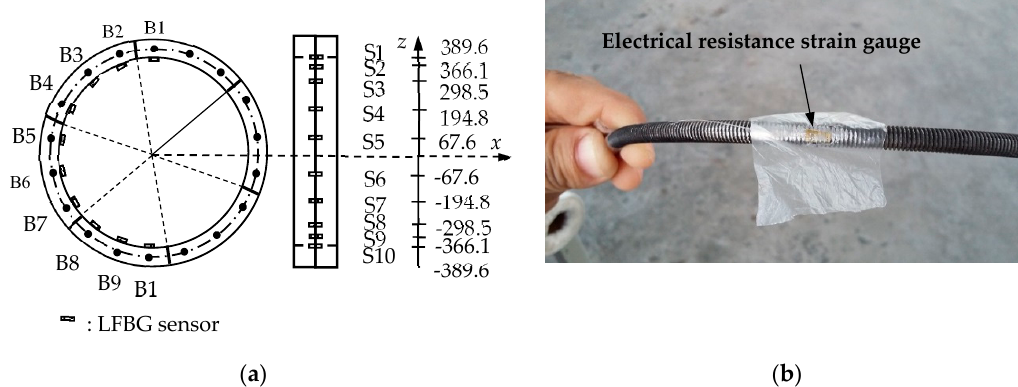
Figure 12. Sensor placement in the scaled-down model. ( a ) S1–S10 (Unit: mm); ( b ) A strain gauge attached to a bolt.